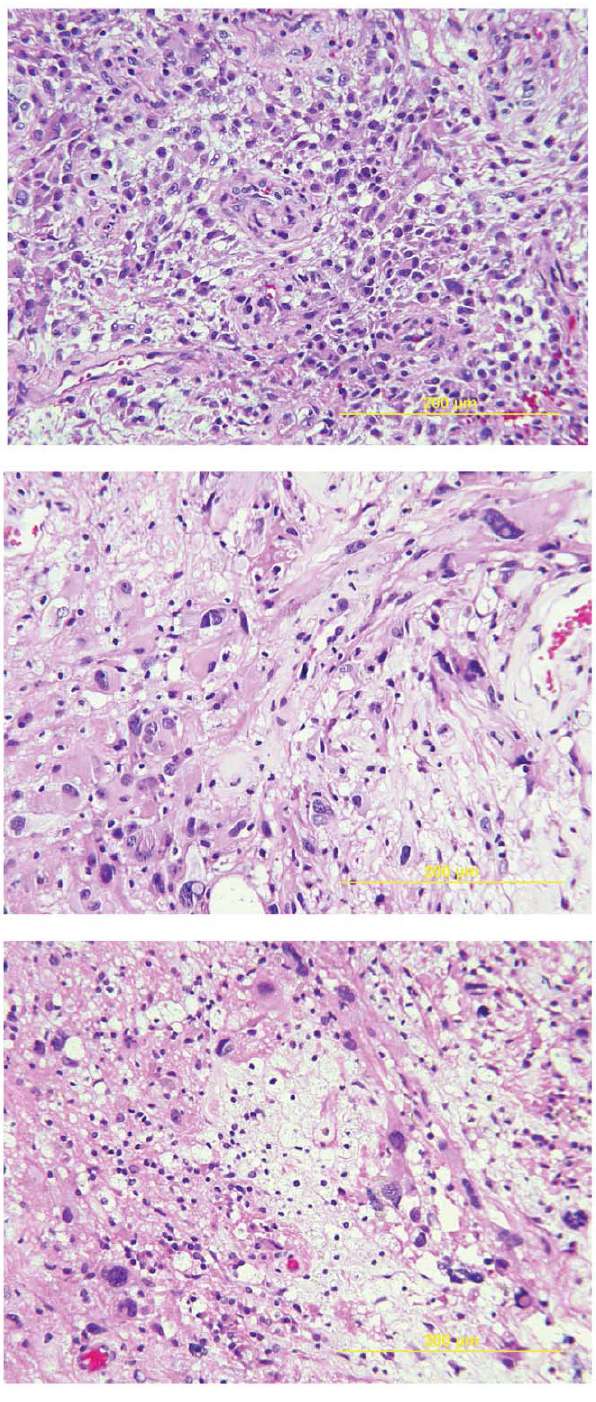
Figure 5. Histopathology of the primary tumor and recurrenc- es. The primary tumor (top) shows uniform cellularity with moderate pleomorphism. The first recurrence (middle) demonstrates marked nuclear pleomorphism and regions of necrosis, while the second recurrence (bottom) shows enlarged, moderately pleomorphic nuclei.